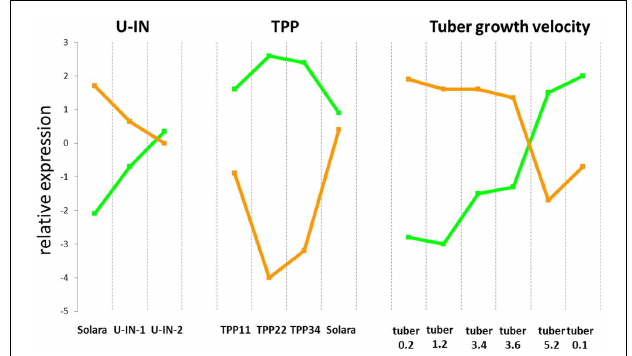
FIGURE 7 | Inverse correlation of GPT2 and Cell wall invertase gene expression. The expression pattern of an EST derived from GPT2 (micro.1076.c1, orange) and cell wall invertase (micro.11340.c1, green) in different U-IN tubers, tubers with altered trehalose-6-phosphate (TPP; Debast et al., 2011) and tubers growing at different velocities (Ferreira et al., 2010).